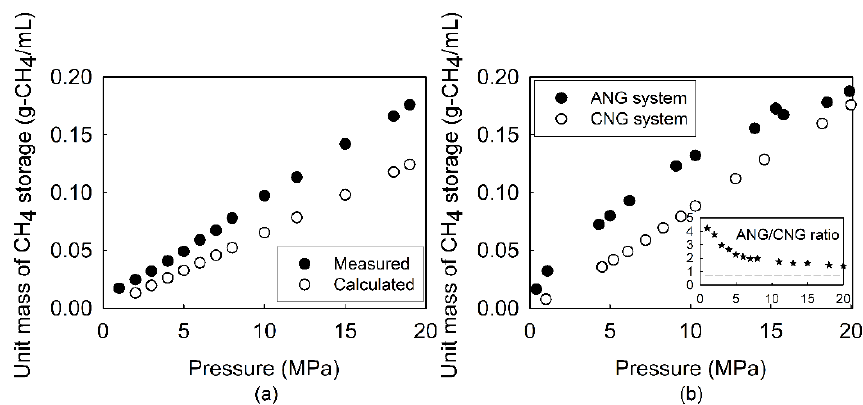
Figure 3. ( a ) Comparison of measured methane storage in the reactor and the calculated methane amount based on the reactor volume at different pressures using the ideal gas law; and ( b ) comparison of methane storage between adsorbed natural gas (ANG) and compressed natural gas (CNG) at different pressures (inset Figure 3b illustrating the ratio for ANG/CNG).